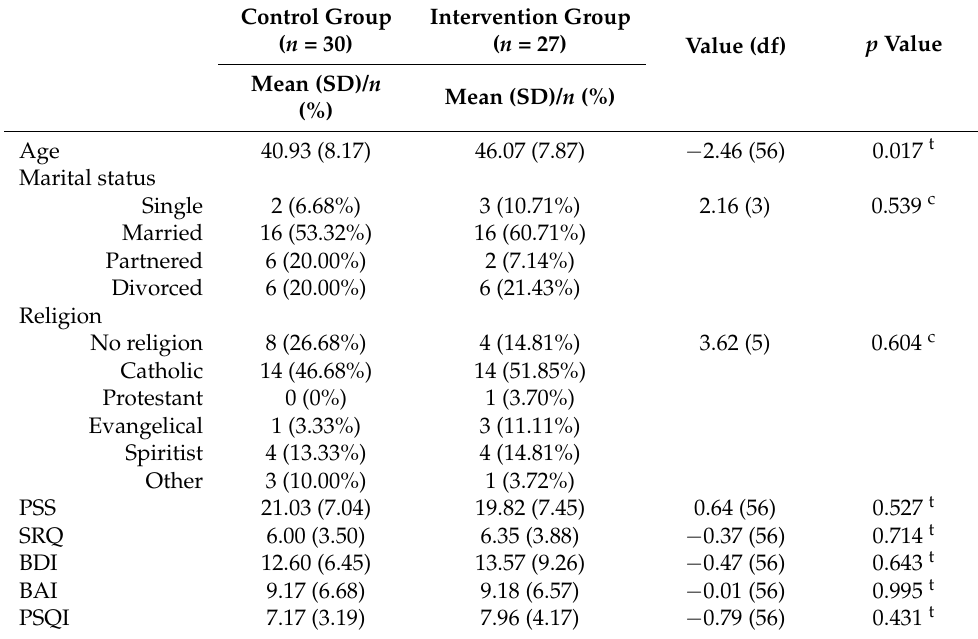
Table 3. Experiment 2: Demographic characteristics at baseline of intervention and control groups.